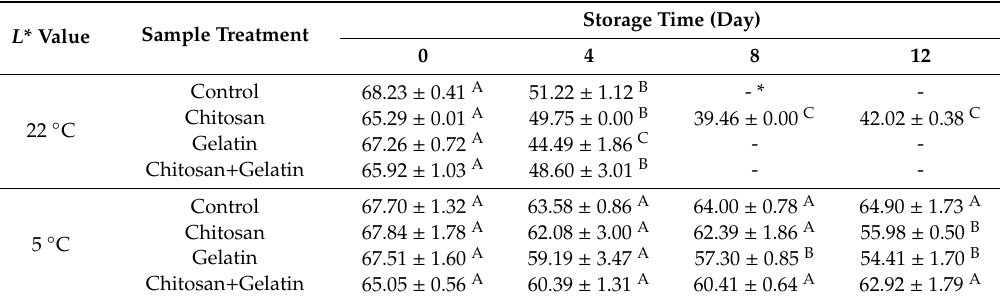
Table 1. L * value changes of cut apple cubes coated with di ff erent coatings and stored at 5 ◦ C and 22 ◦ C for 12 days.